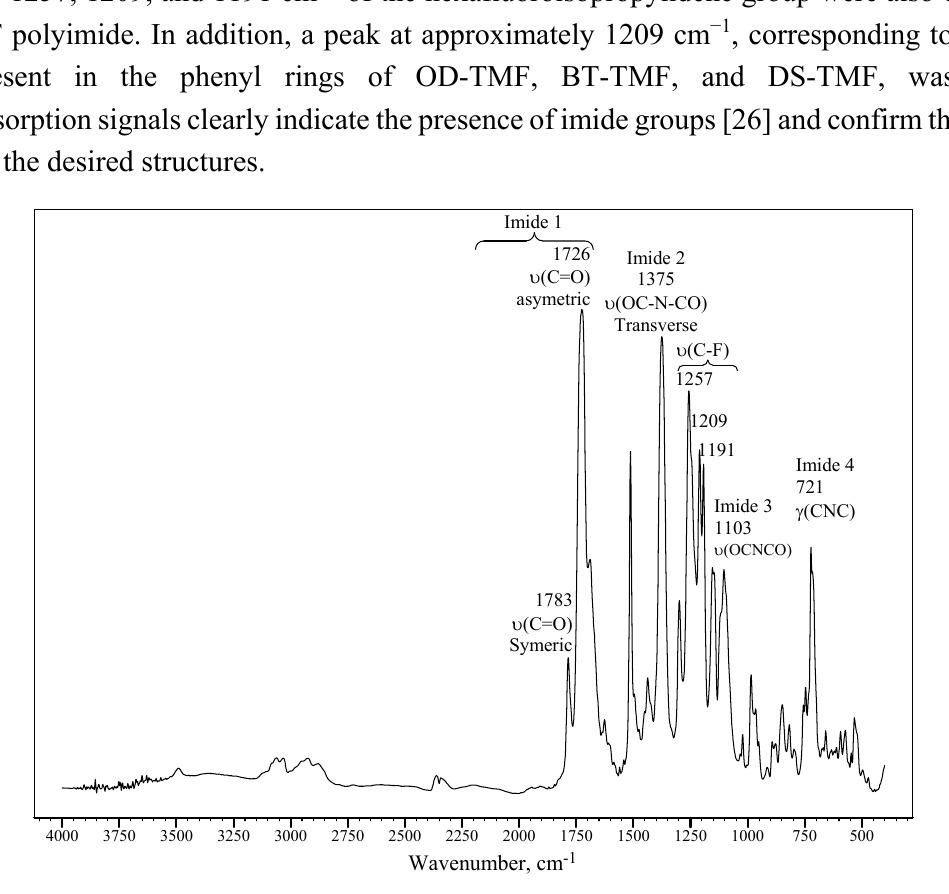
Figure 2. FTIR spectra determined for a 6F-TMF polyimide synthesized in this